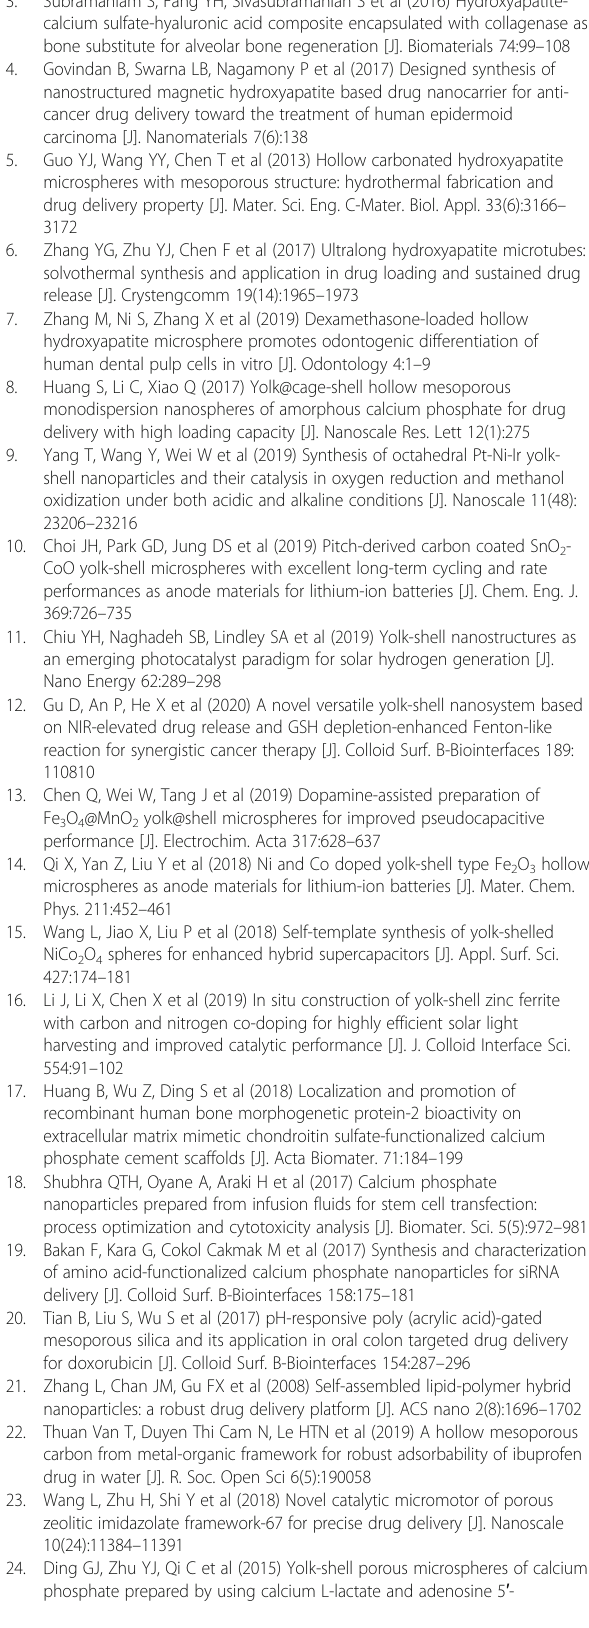
Additional file 1: Figure S1. DTA curves of ATP-CG microspheres synthesized with Ca/P = 3.3 under different experimental